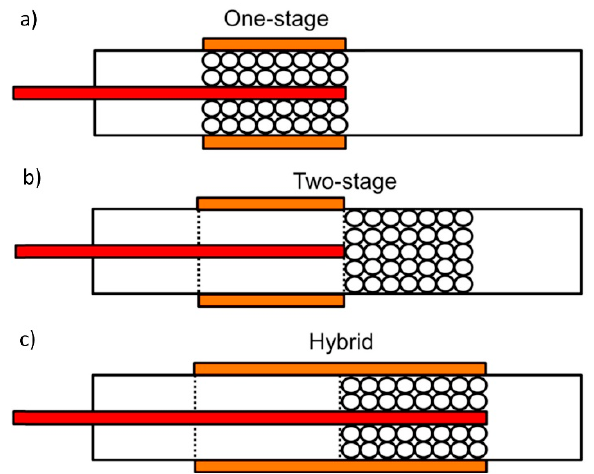
Figure 24. Different configurations of non-thermal plasma reactors. ( a ) One-stage, ( b ) two-stage, and ( c ) hybrid plasma reactors. Reprinted from Reference [93], with permission from Elsevier.